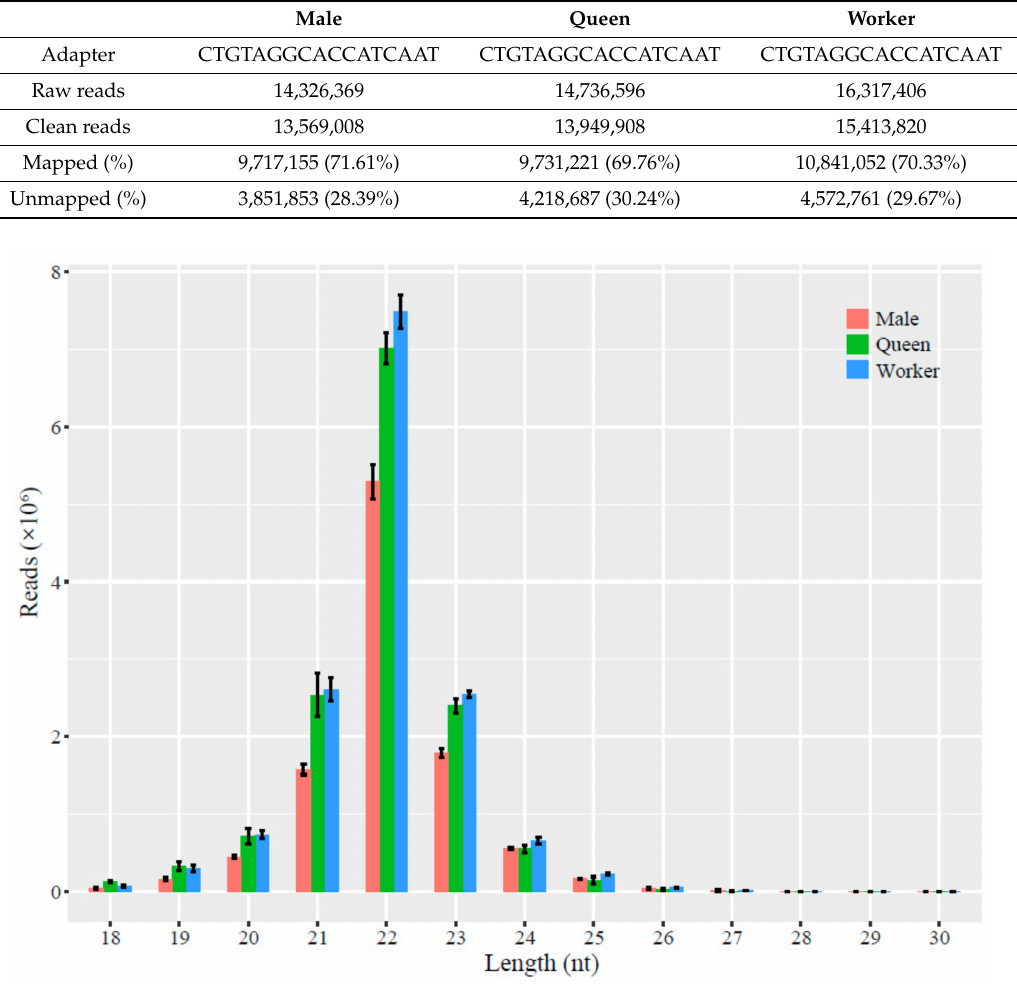
Figure 1. Distribution of the lengths of the small RNA reads in the three B. lantschouensis castes. The black vertical lines represent error bars. The size distribution of the 18–30 nt clean reads obtained from all three groups was assessed. Most sequences in the three libraries were 21–23 nt in length, and the most abundant size was 22